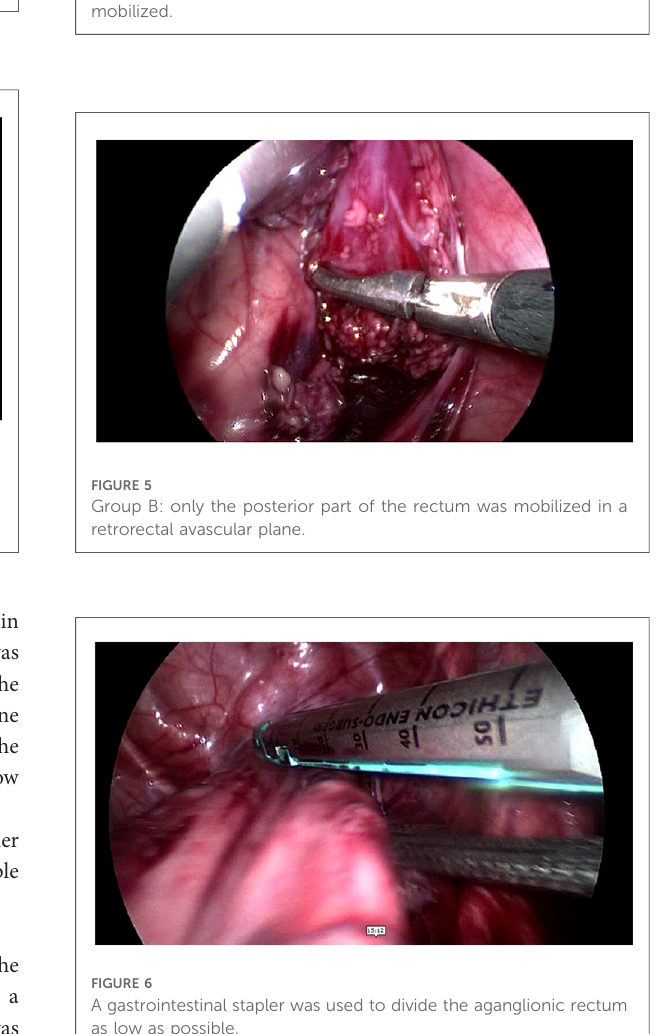
FIGURE 2 Mobilization of the proximal part.